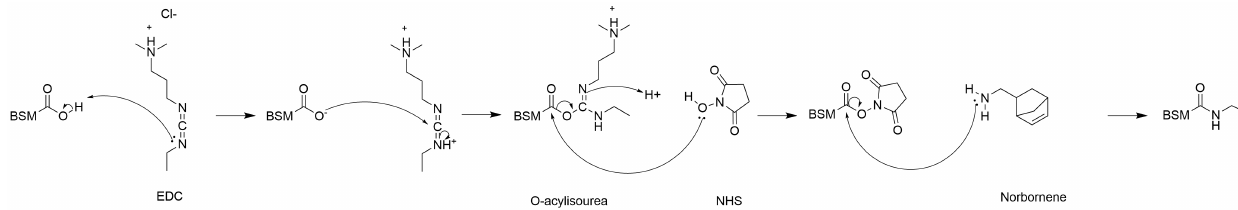
Figure A1. EDC NHS coupling (tetrazine).